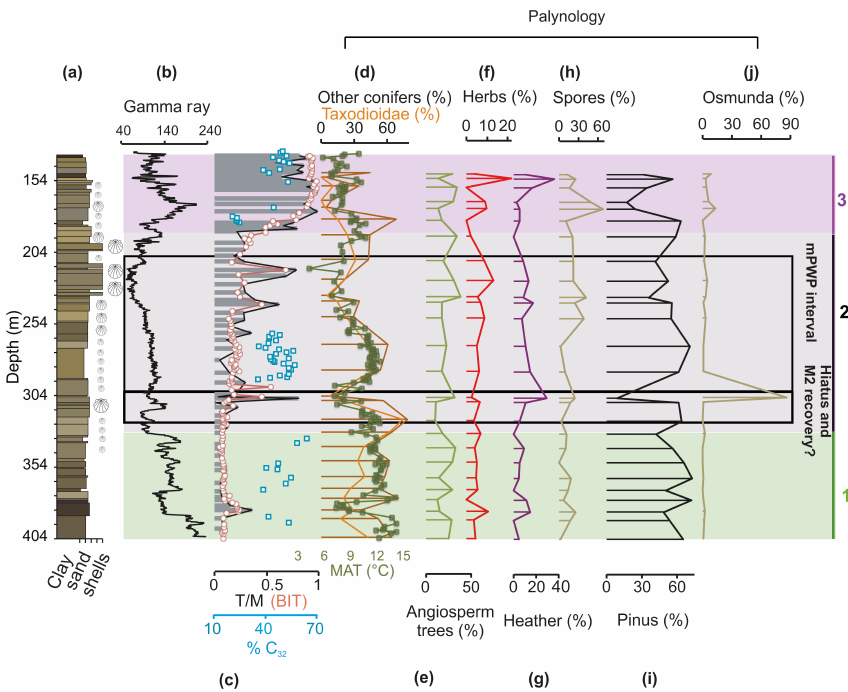
Figure 4. Terrestrial proxies for the Hank borehole. (a) The depth and lithology of the Hank sediments, with shell material qualitatively indicated by shell symbols. (b) The smoothed gamma ray (GR) log (from https://www.dinoloket.nl, last access: 15 April 2019) and (c) the relative input of terrestrial organic material to the Hank sediments based on the terrestrial/marine ratio of palynomorphs (black line), the Branched and Isoprenoid Tetraether (BIT) index (orange circles), and the percent of C 32 diol (blue squares). Pollen records expressed as percent of total pollen: (d) other conifers (brown line), Taxodioidae (orange line) and MAT (in degrees Celsius; green line; Dearing Crampton- Flood et al., 2018), (e) angiosperm trees, (f) herbs, (g) heather, (h) spores, (i) Pinus , and (j) Osmunda . Intervals 1, 2, and 3 discussed in the text are indicated by green (early Pliocene), grey (mid-Pliocene), and purple (late Pliocene–early Pleistocene). The tuned interval and the position of the hiatus marking the M2 glacial event are represented by a black